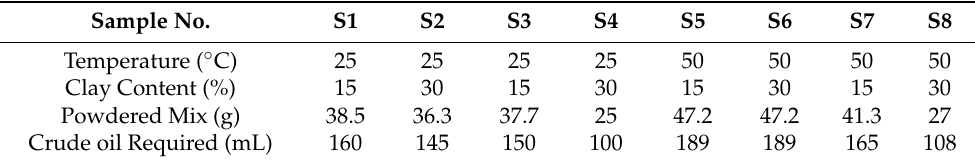
Table 3. Quantity of crude oil required for each